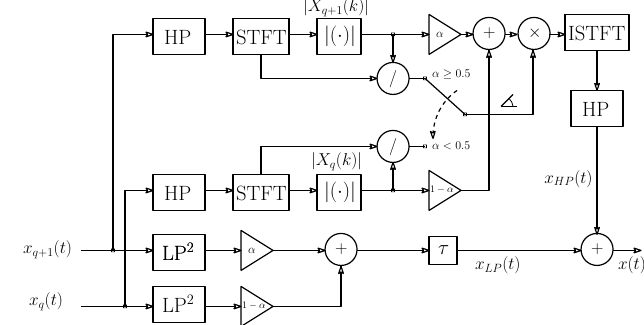
( b ) Block diagram of the LISHPh interpolation method. The lower band is interpolated linearly in the time domain, while the high-frequency band is interpolated in the short-time Fourier domain. The high-frequency signal is obtained by a magnitude interpolation and the phase for reconstruction is chosen dependent on α (interpolation weight). Figure 2. Block diagram for BRIR selection, convolution, and continuous interpolation for one ear in a dynamic binaural rendering